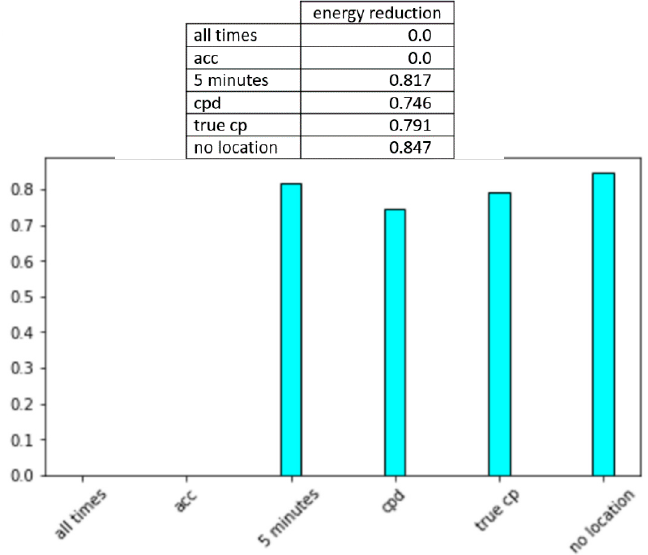
Figure 12. Percentage reduction in energy consumption in comparison with continuous sampling of movement and location.